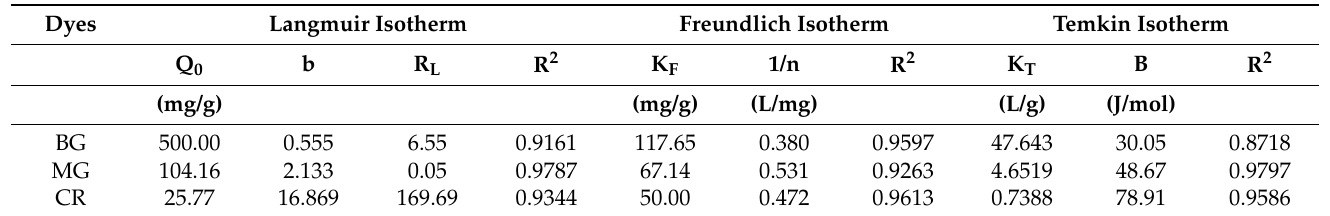
Table 3. Comparison of adsorption capacity of various adsorbents reported in the removal of dyes. Sl. No.